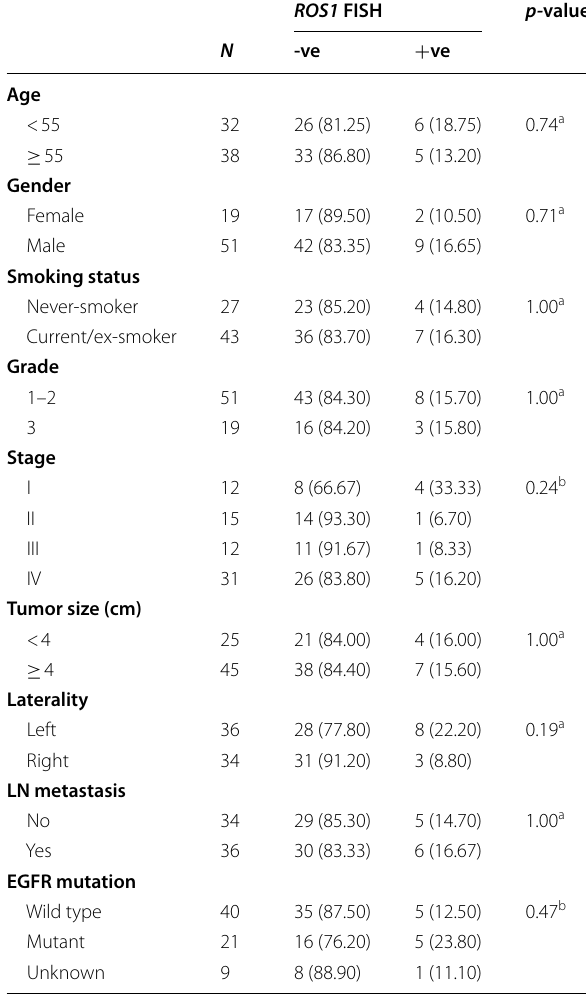
Table 3 Clinicopathological characteristics in association with ROS1 gene